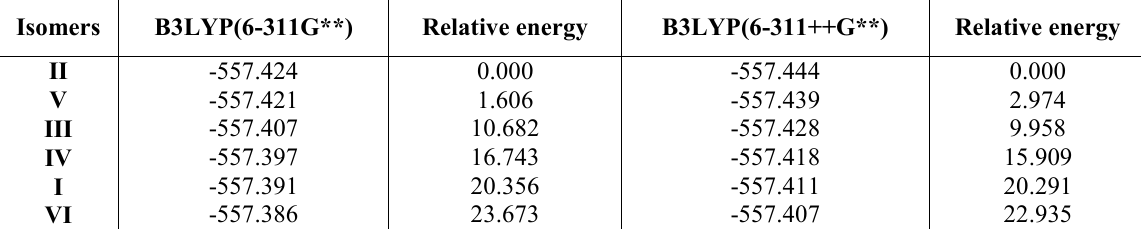
Table 2. Energies (Hartree) and Relative Energies (kcal/mol) of Optimized Isomers (B3LYP/6-311G**, 6-311++G**) of the Isolated Glycylglycine–Zn 2+ Complexes in Gas Phase.